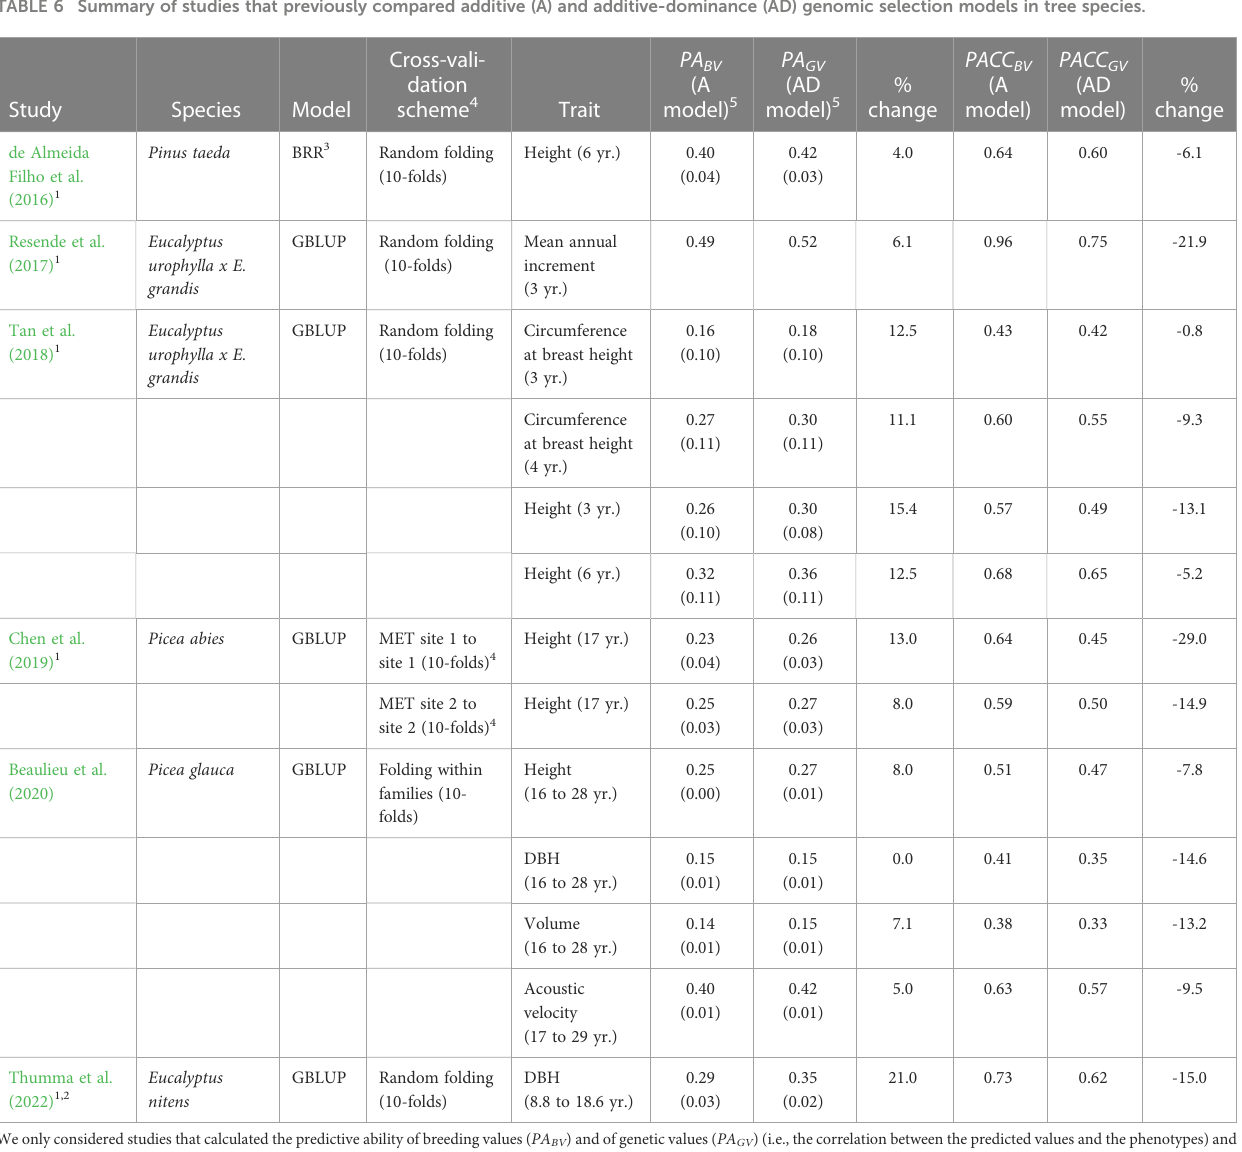
TABLE 6 Summary of studies that previously compared additive (A) and additive-dominance (AD) genomic selection models in tree